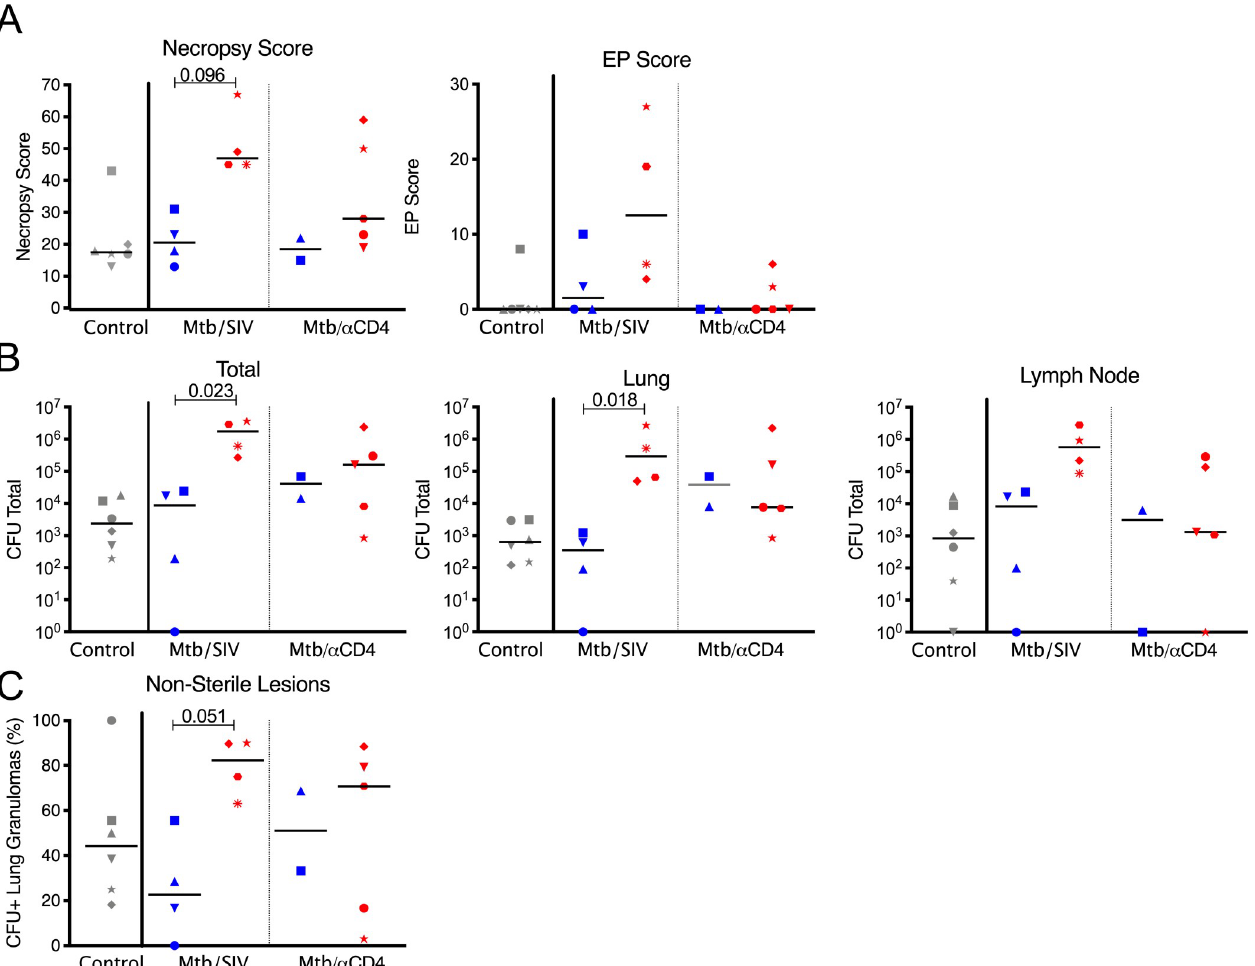
Fig 2. Subclinical reactivation of Mtb/SIV NHP results in greater total thoracic burden but not in Mtb/ α CD4 NHP. Non-reactivators (blue) and reactivators (red) from Mtb only (control, grey), Mtb/SIV co-infected (n = 8), and CD4 depletion (Mtb/ α CD4, n = 7) NHP are shown. Individual monkeys are identified by different shapes. A) Necropsy and extrapulmonary (EP) scores are based on gross pathology at time of necropsy. B) Total thoracic burden (quantitative sum of Mtb from excised tissues within the thoracic cavity) and lung and thoracic lymph nodes are shown. C) A greater percentage of granulomas with Mtb growth is observed in reactivated Mtb/SIV NHP. P-values reported from Kruskal-Wallis test with Dunn’s multiple comparisons adjustments, adjusted for the following (4) comparisons: reactivators vs non-reactivators within treatments and non-reactivators and reactivators between treatments. P-values < 0.10 are shown. Mtb-only controls are shown for reference, but not included in the statistical